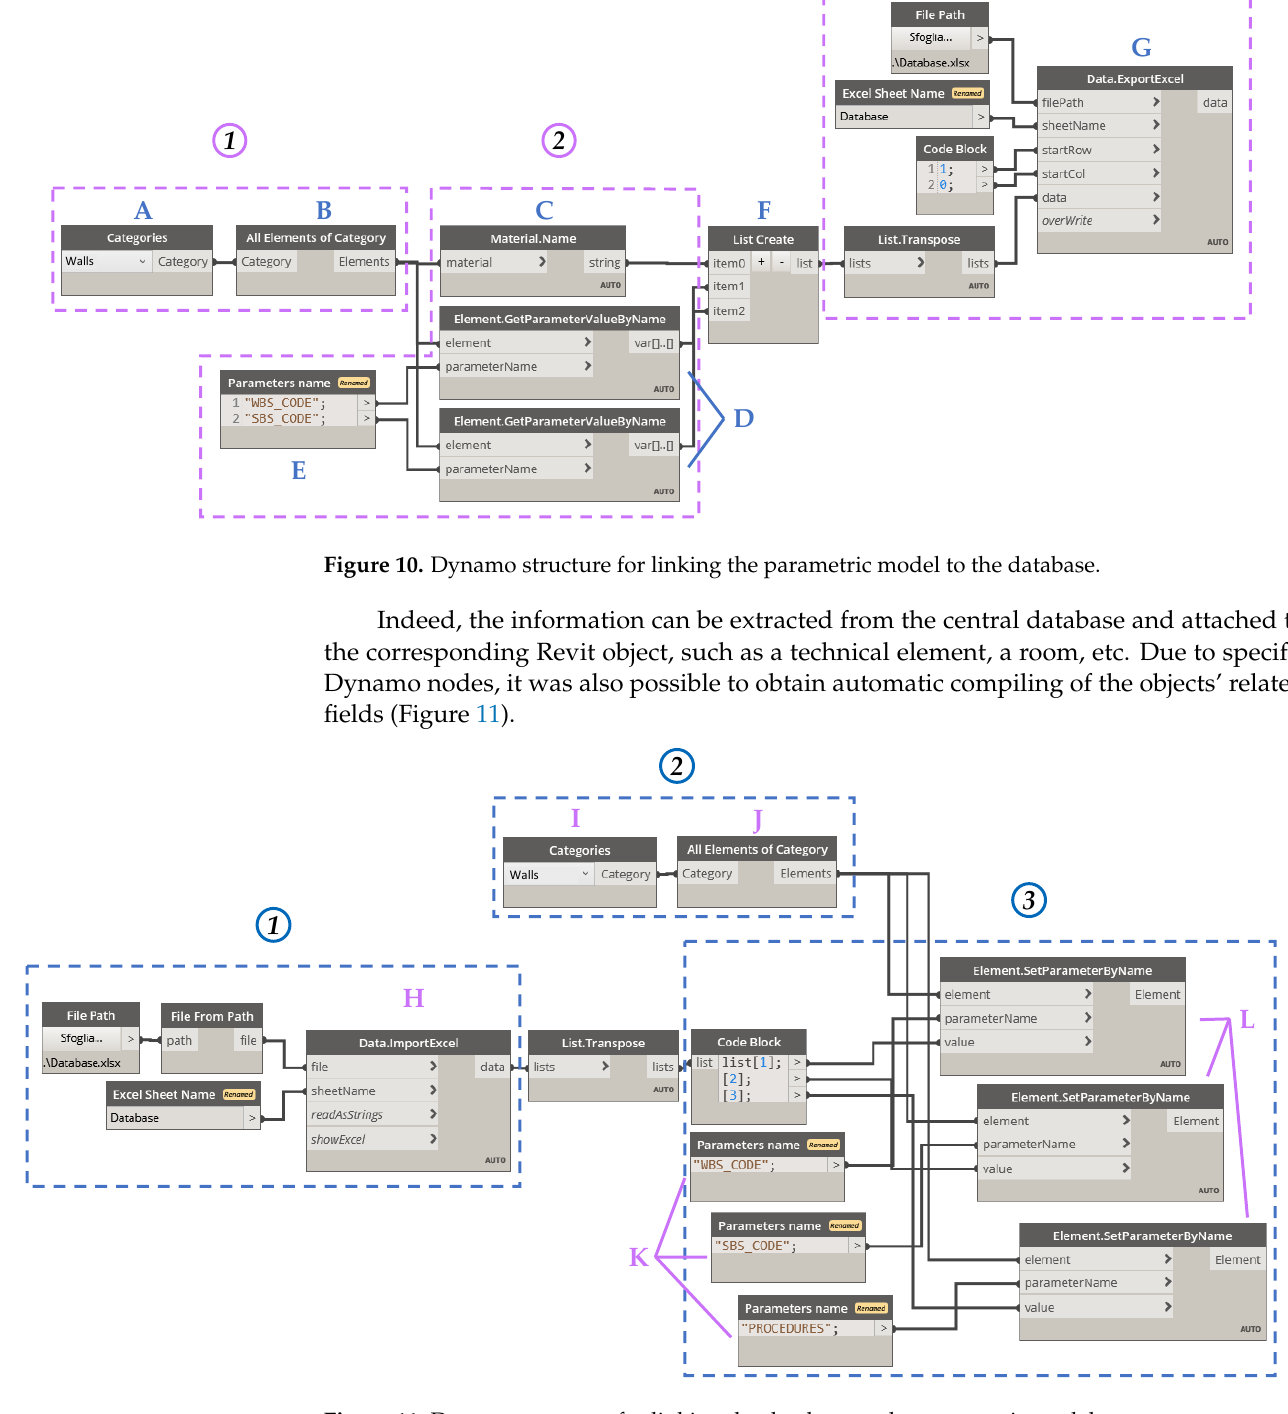
Figure 11. Dynamo structure for linking the database to the parametric model. As highlighted before, Dynamo is based on a structure of “functional nodes”, through which it is possible to run specific features. This information string involves input and output data. Each individual node performs a specific action. This action can be a simple activity, such as extrapolating a single value, or, on the other hand, it can be a complex process, such as that linked to generative design trials. The visual programming